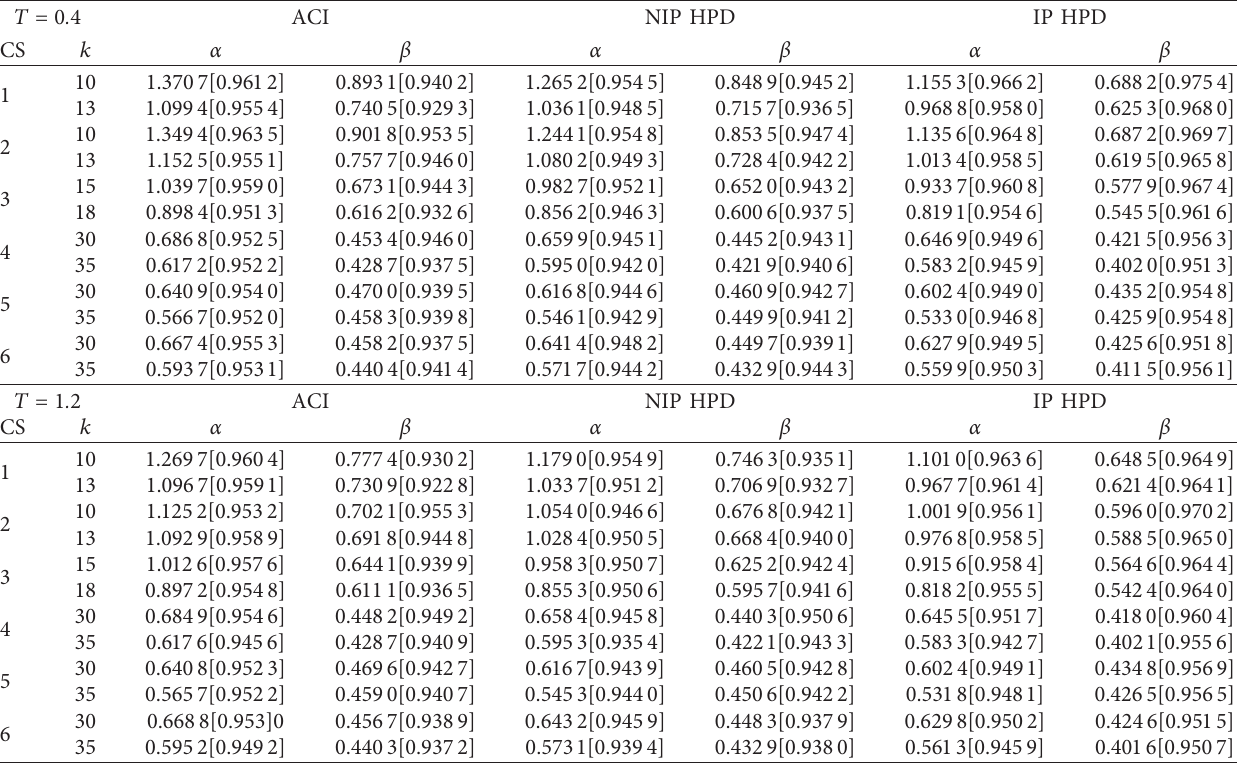
Table 2: AWs and CPs (within brackets) of the ACIs and HPD credible intervals under generalized progressively hybrid censored data with ( α , β ) � ( 1 , 0 . 6 )